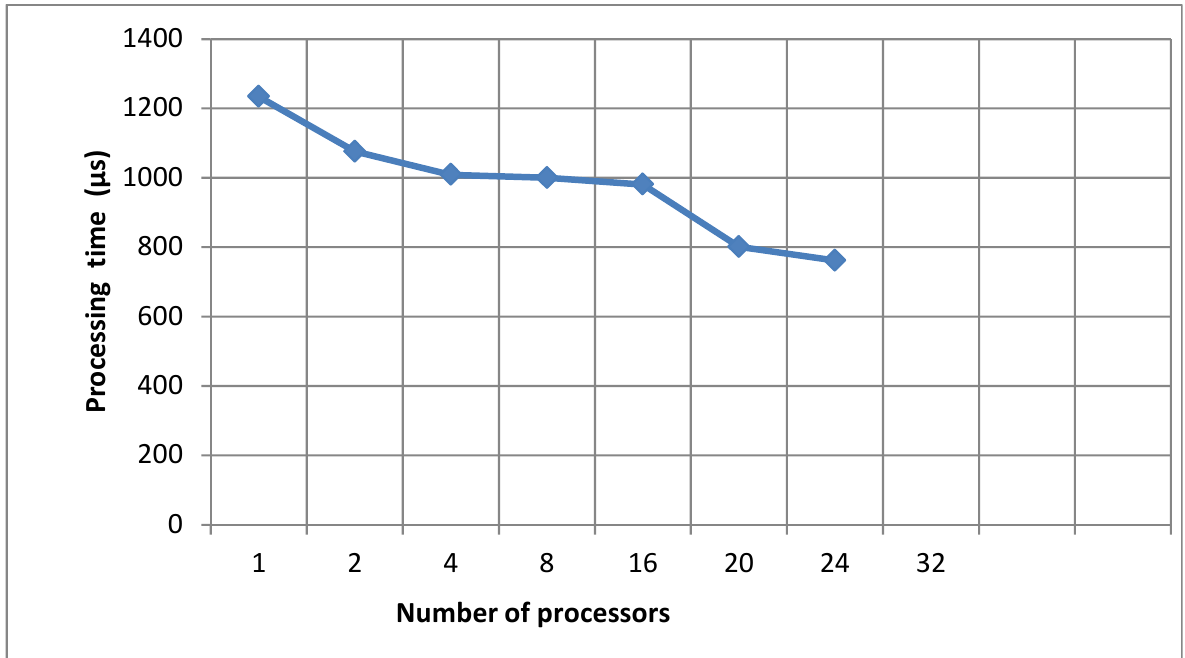
Figure 9. Dependence of SVD processing time on the number of computing processors at a matrix size of 200 × 200.